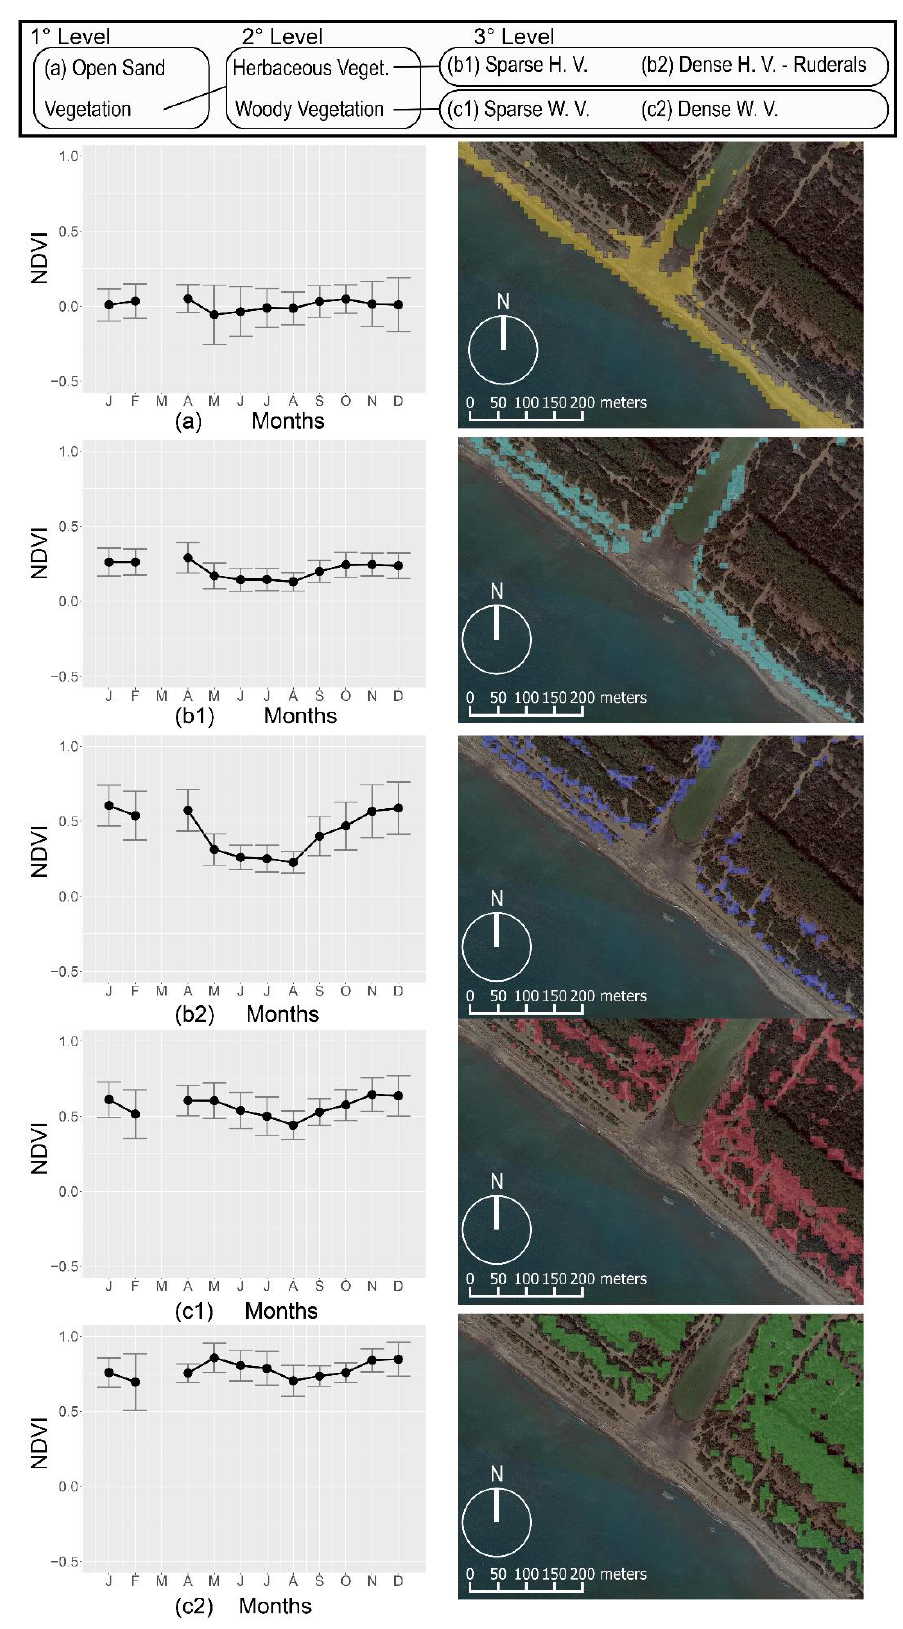
Figure 3. Cartesian diagrams (on the left) of NDVI values with average ± standard deviation ( y -axis) for each month of the year except March ( x -axis) of the five phenology-based classes identified by multitemporal classification of Sentinel-2 images, along with mapping examples (on the right) projected on Google Earth View.